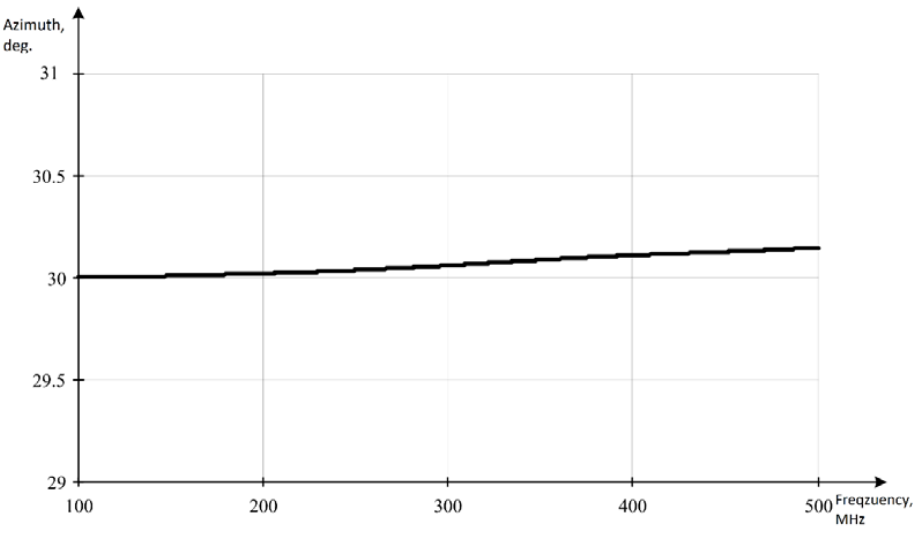
Figure 26. Calculated azimuth of the source in the frequency band from 100 to 500 MHz (the true value of the azimuth is 30 degrees).